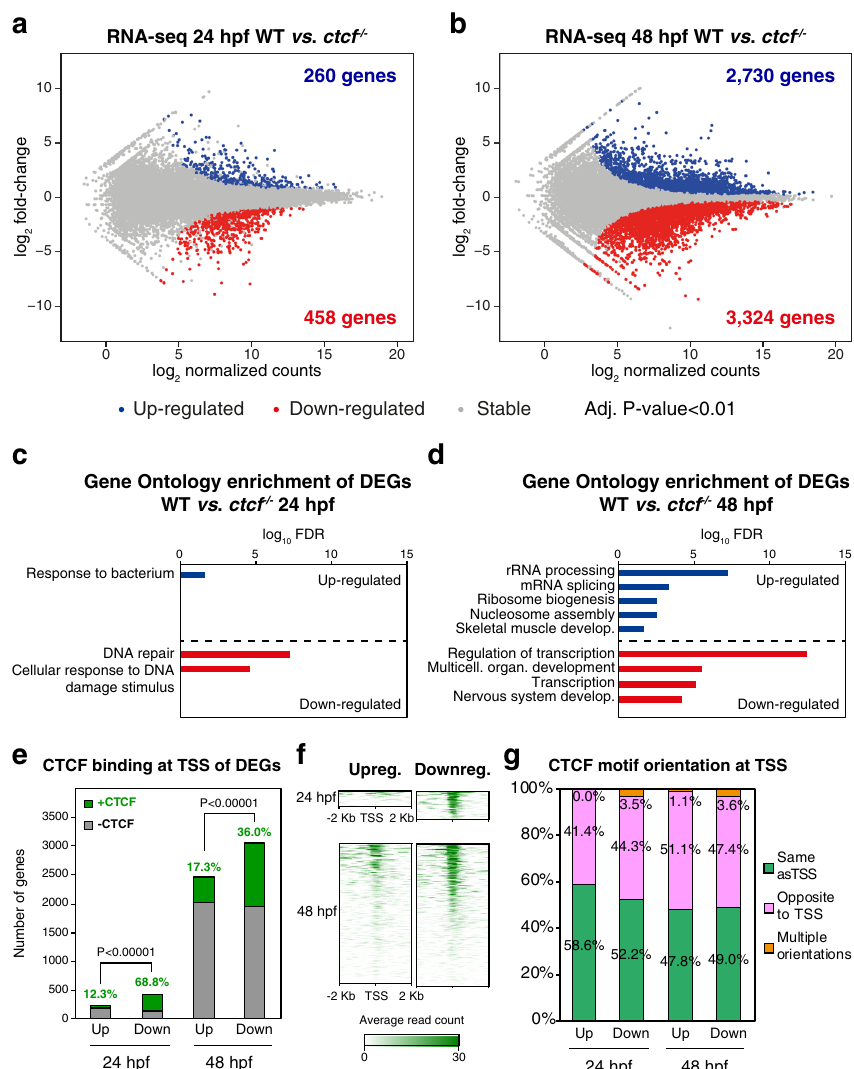
Fig. 2 CTCF absence in zebra fi sh embryos leads to altered developmental gene expression. a , b Differential analyses of gene expression between WT and ctcf − / − embryos at 24 ( a ) and 48 hpf ( b ) from RNA-seq data ( n = 2 biological replicates per condition). The log 2 normalized read counts of WT transcripts versus the log 2 fold-change of expression are plotted. Transcripts showing a statistically signi fi cant differential expression (adjusted P - value < 0.01) are highlighted in blue (upregulated) or red (downregulated). The number of genes that correspond to the upregulated and downregulated transcripts are shown inside the boxes. c , d Gene Ontology (GO) enrichment analyses of biological processes for differentially expressed genes (DEGs) in ctcf − / − embryos at 24 ( c ) and 48 hpf ( d ). Terms with a false discovery rate (FDR) < 0.05 are shown and considered as enriched. e Number of differentially expressed genes (DEGs) at 24 and 48 hpf showing (green) CTCF binding at their transcription start sites (TSS) or not (gray). f Heatmaps showing CTCF ChIP-seq signal around the TSS of DEGs at 24 and 48 hpf. g Percentage of CTCF motif orientation at ChIP-seq peaks overlapping TSS and relative to transcriptional